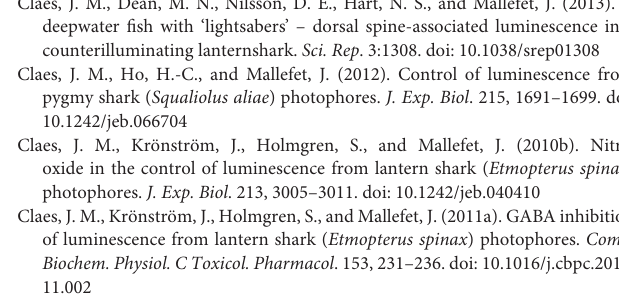
Supplementary Table 1 | Experimental specimens. Morphometrics measurements of Dalatias licha , Etmopterus lucifer , E. granulosus , Squaliolus aliae and I. brasiliensis studied specimens. Supplementary Table 2 | Photophore density, statistical analyses. Results of Tukey’s test for the photophore density of (A) D. licha, (B) E. lucifer, and (C) E. granulosus different skin zones. Gray-shaded cases represent not significant differences. Supplementary Table 3 | Hormone-induced luminescence parameters (mean maximal light intensity: Lmax; time to reach the Lmax: TLmax; total amount of emitted light: Ltot; total amount of emitted light after second drug application: Ltot app ). (A) luminescence recorded parameters for the melatonin (MT) dose response treatments for Dalatias licha ( n = 12), Etmopterus lucifer ( n = 7) and